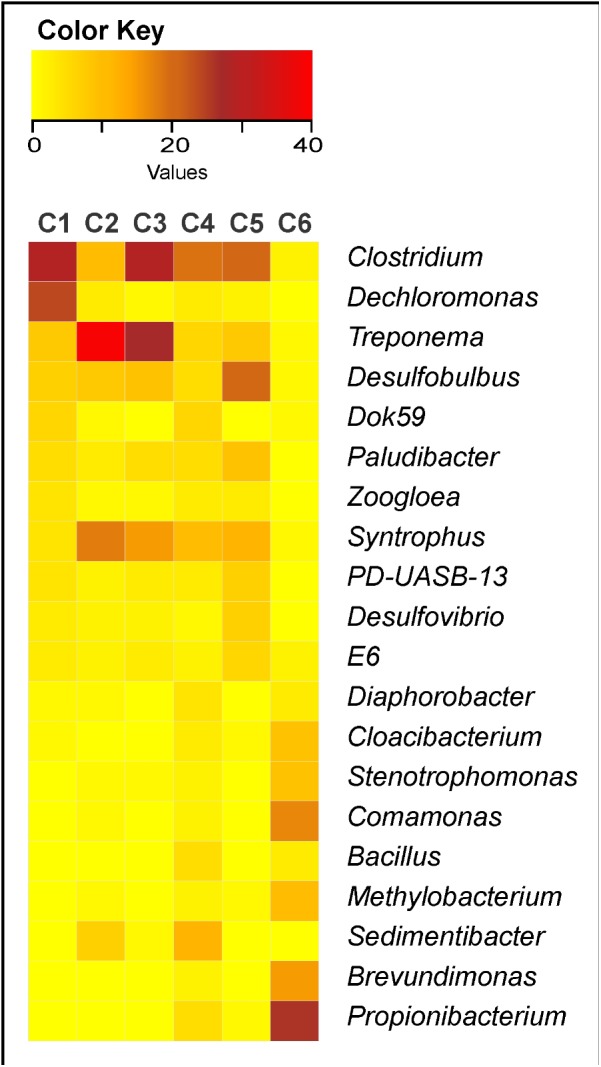
Heatmap of the 20 most abundant bacterial genera found in 19 sewage sludges from São Paulo State, Brazil. C1, cluster 1 (n = 3 samples); C2, cluster 2 (n = 2 samples); C3, cluster 3 (n = 2 samples); C4, cluster 4 (n = 6 samples); C5, cluster 5 (n = 4 samples); and C6, cluster 6 (n = 2 samples). Red color, most abundant genus; Yellow, least abundant genus.